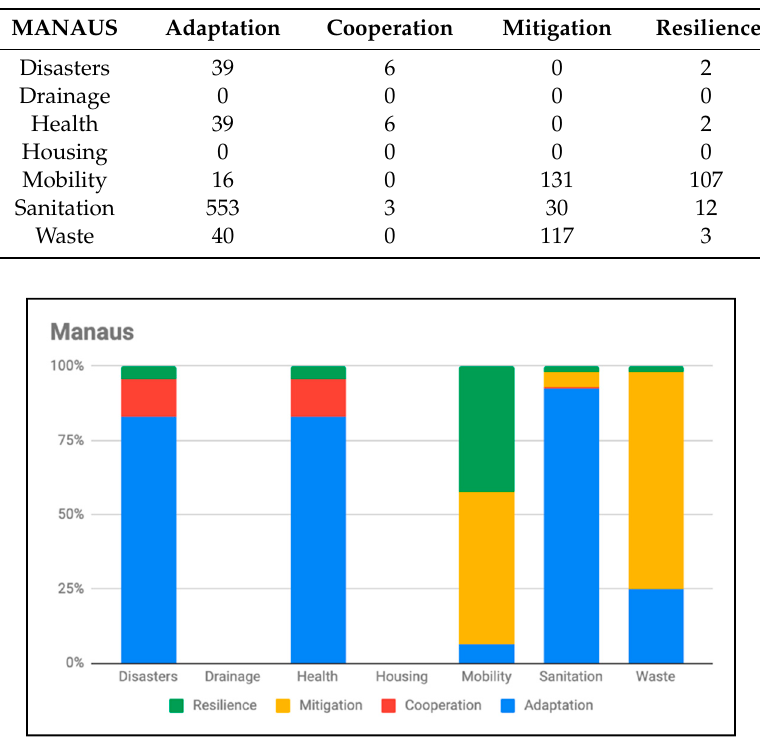
Figure 12. Climate action references in Manaus’ sectoral plans. Table 12. Climate action references in Salvador’s sectoral plans.